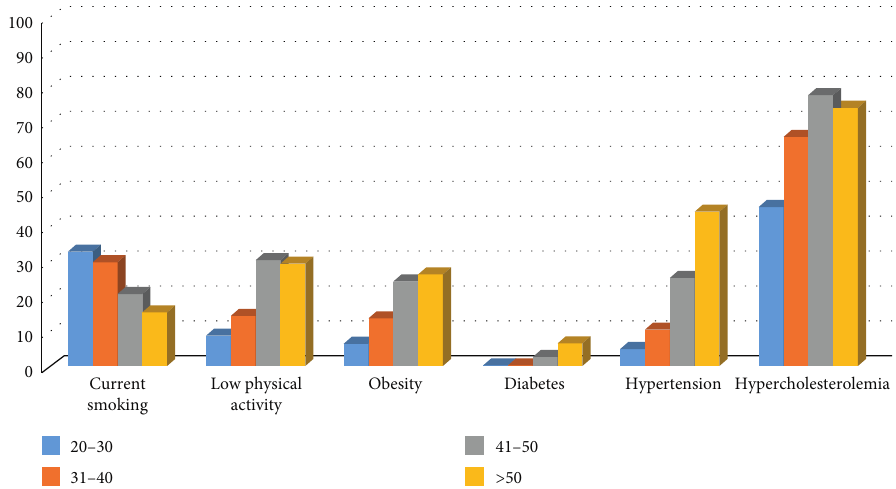
Figure 1: Distribution of risk factors divided by age (age groups: 20–30, 31–40, 41–50 and > 50 years of age). Scale on the left shows percentage of soldiers with risk factor. Obesity: BMI > 30kg/m 2 ; hypercholesterolemia: LDL cholesterol >